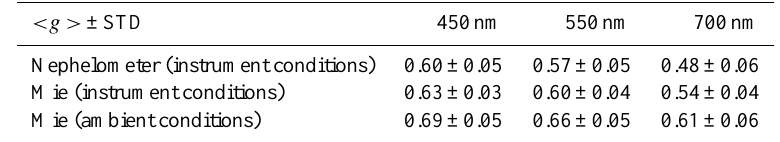
Table 1. Asymmetry parameter.